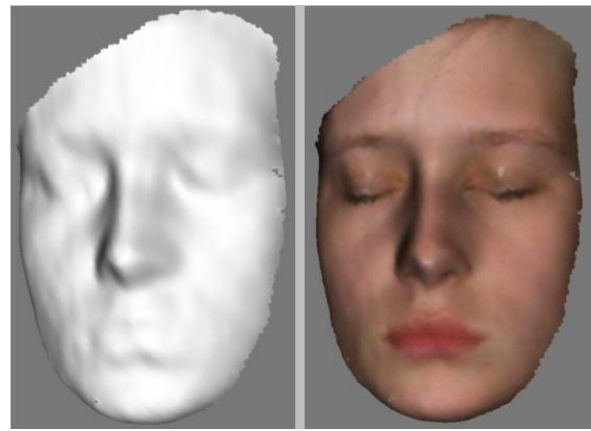
Figure 5. Sample of face 3-D